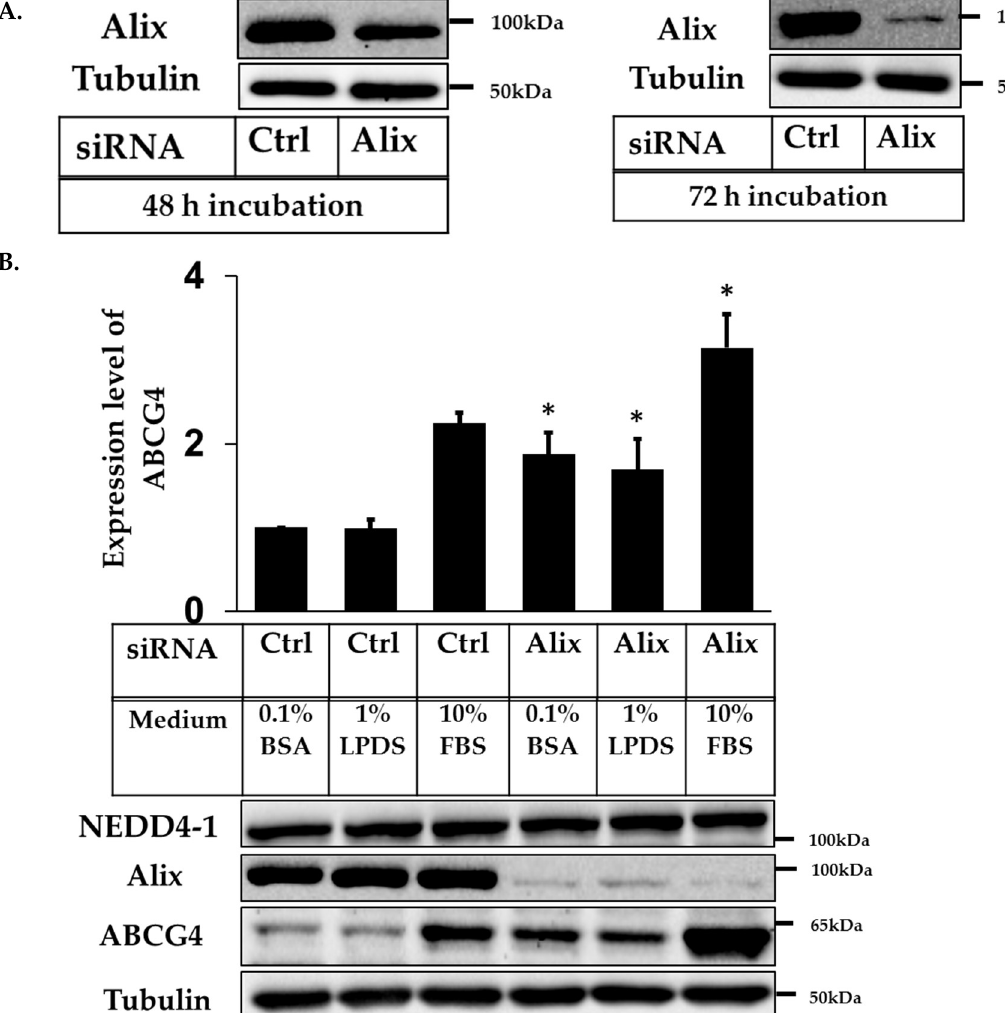
Figure 6. siRNA knockdown of Apoptosis-linked gene 2-interacting protein X (Alix) increases ABCG4 protein expression. ( A ) Immunoblots of cell lysates from ABCG4-CHOK1, transfected with either control or Alix siRNA. ( B ) Quantification of ABCG4 protein relative to tubulin in low and normal serum conditions (mean ± SEM of three independent experiments, each performed in duplicate cultures, and expressed as fold change relative to control 0.1% BSA). * indicates p < 0.05 compared to control.